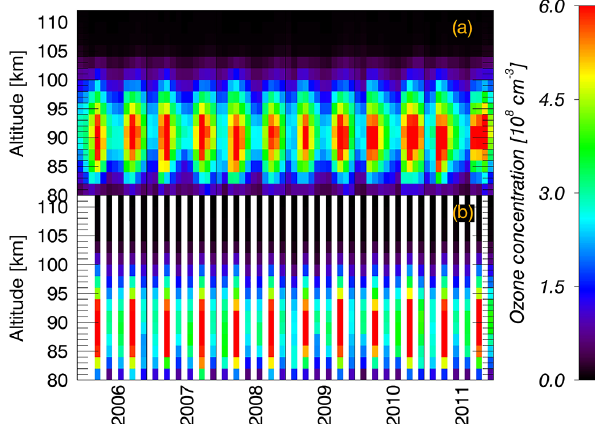
Figure 12. Comparison of ozone profiles from SABER mea- surements used to retrieve sodium concentrations from (a) SCIA- MACHY and (b) OSIRIS mesospheric nighttime limb measure-